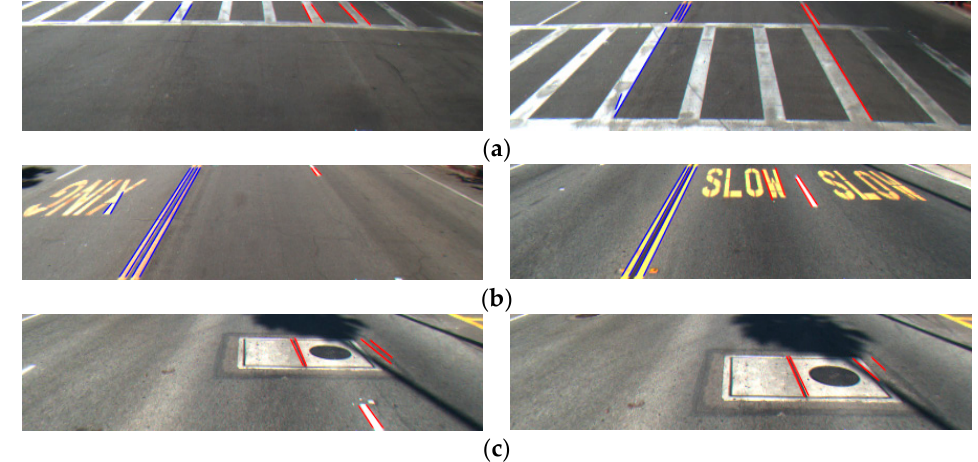
Figure 13. Examples of false detection: ( a ) crosswalk; ( b ) symbol markings of indicating word; and ( c ) non-road objects.